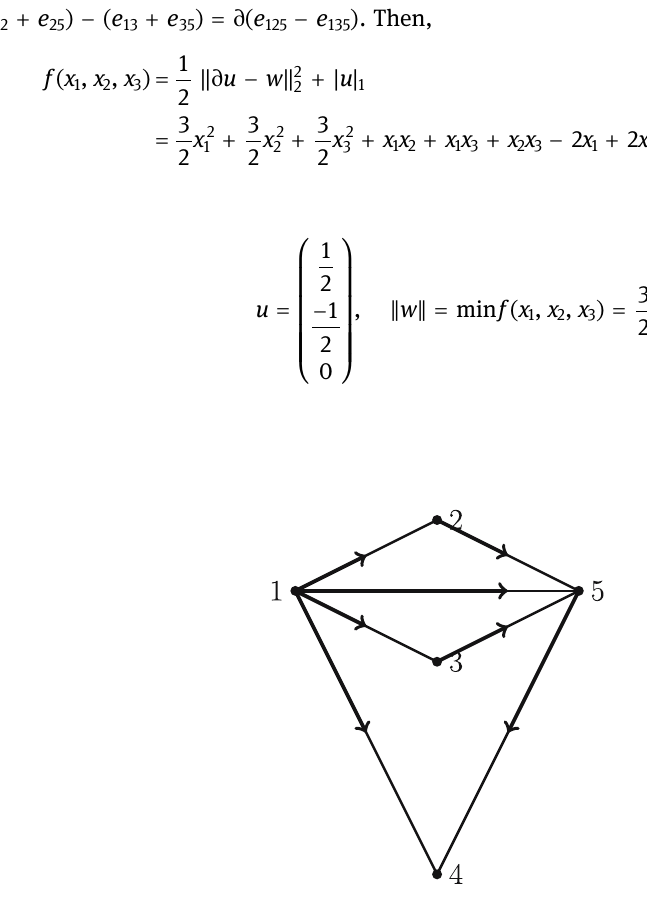
Figure 3: Example